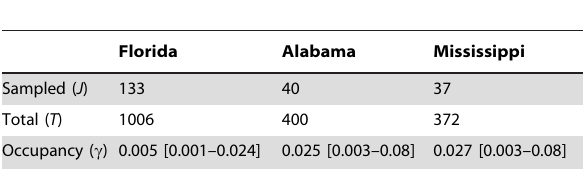
Table 1. Estimates of occupancy rate ( c ) of manatees in three regions (Florida, Alabama and Mississippi) that were affected by the Deepwater Horizon oil